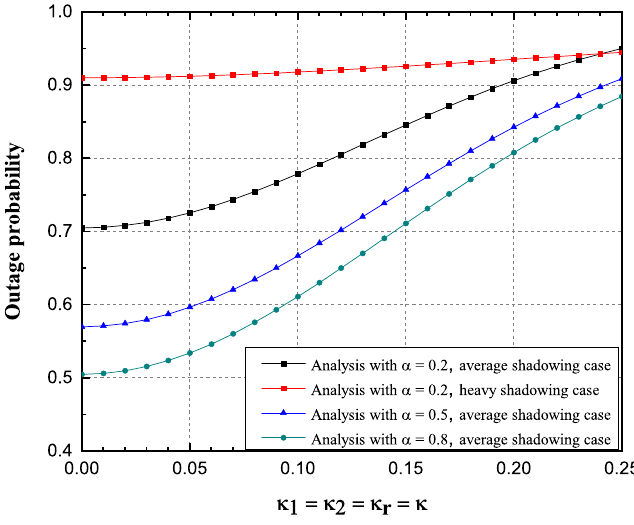
Figure 8. Rician-shadowed fading channels: Outage probability versus κ .